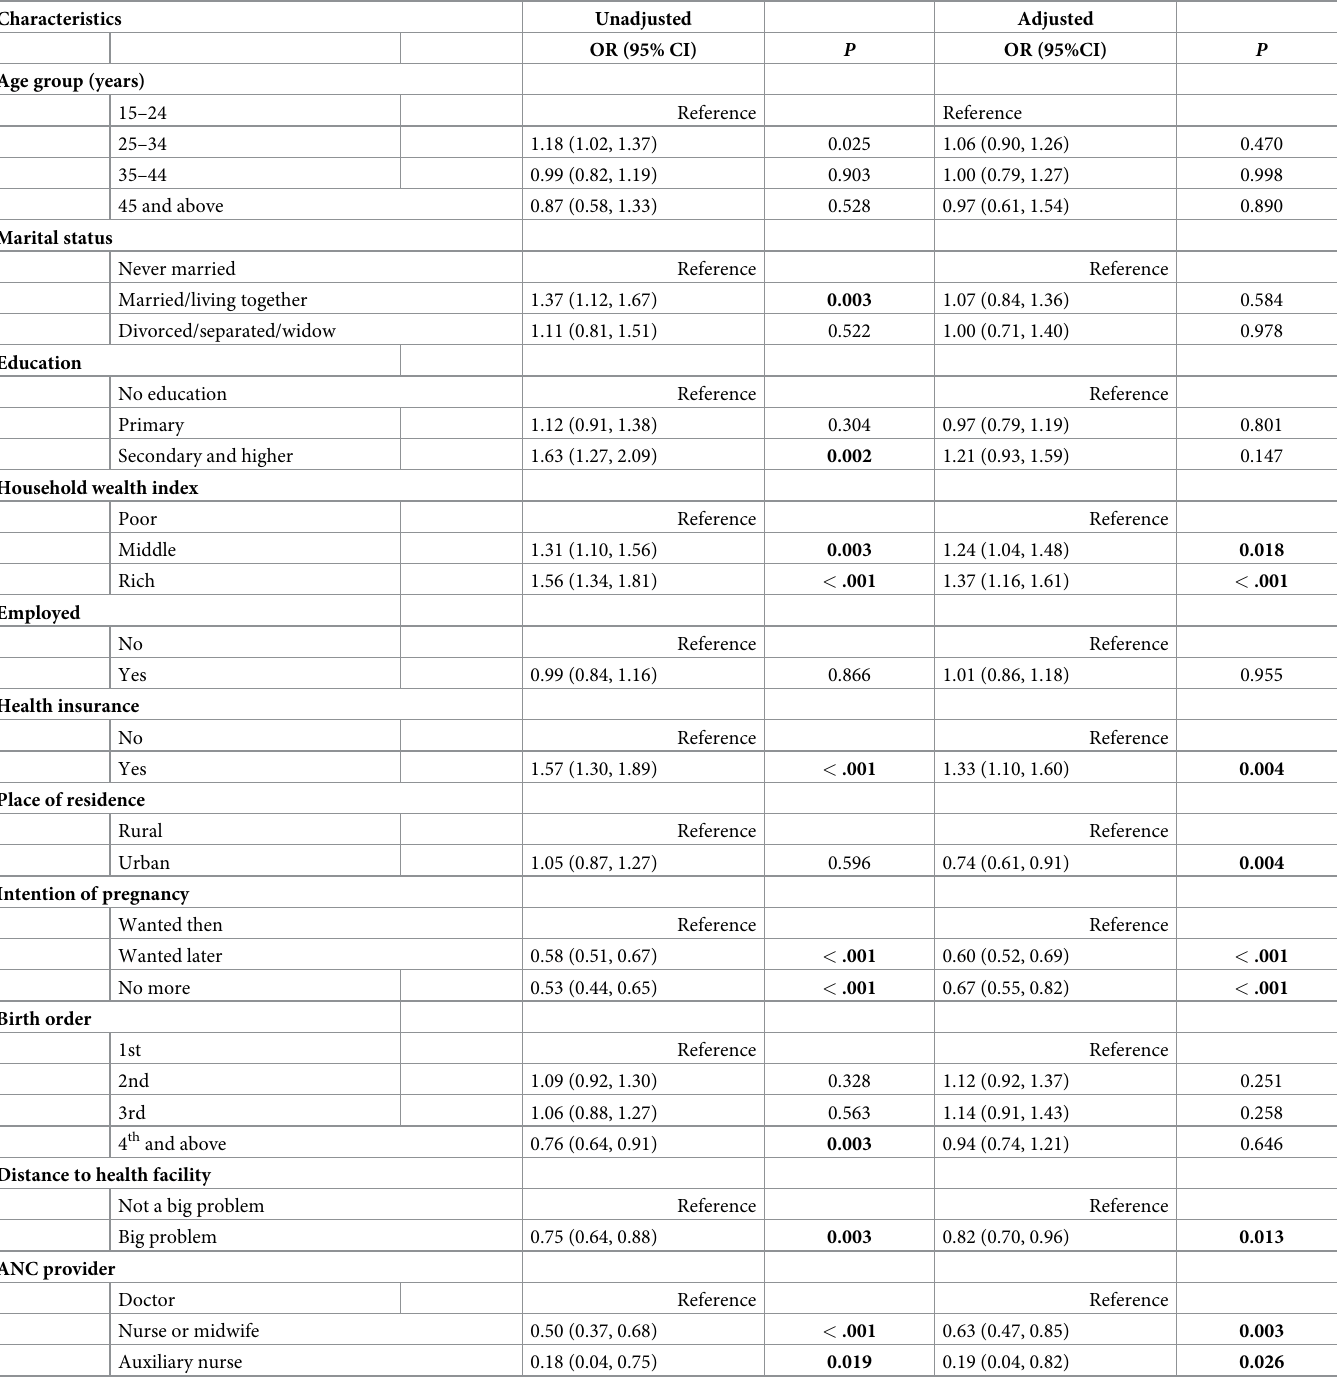
Table 3. Factors associated with receipt of adequate ANC (n =